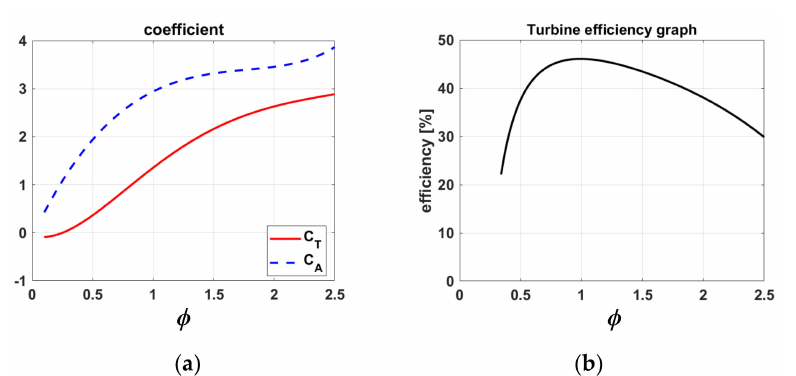
Figure 2. Turbine characteristics: ( a ) Input and torque coe ffi cients; ( b ) turbine e ffi